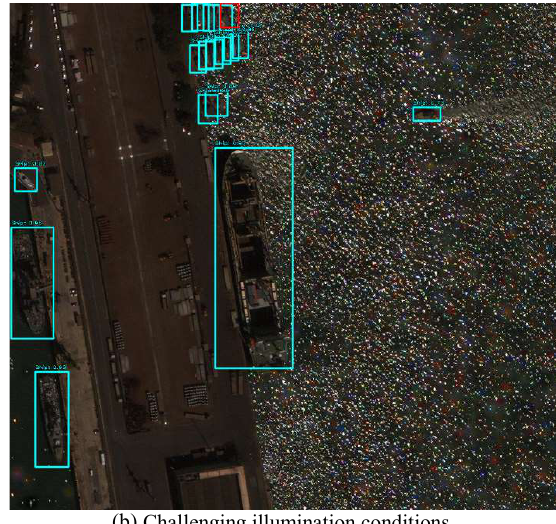
Figure 3. RetinaNet detection results in various environments (light blue = TP, yellow = FP, red = FN). Image chips are 1024 x 1024 pixels in size, corresponding to a ~ 350 m side.